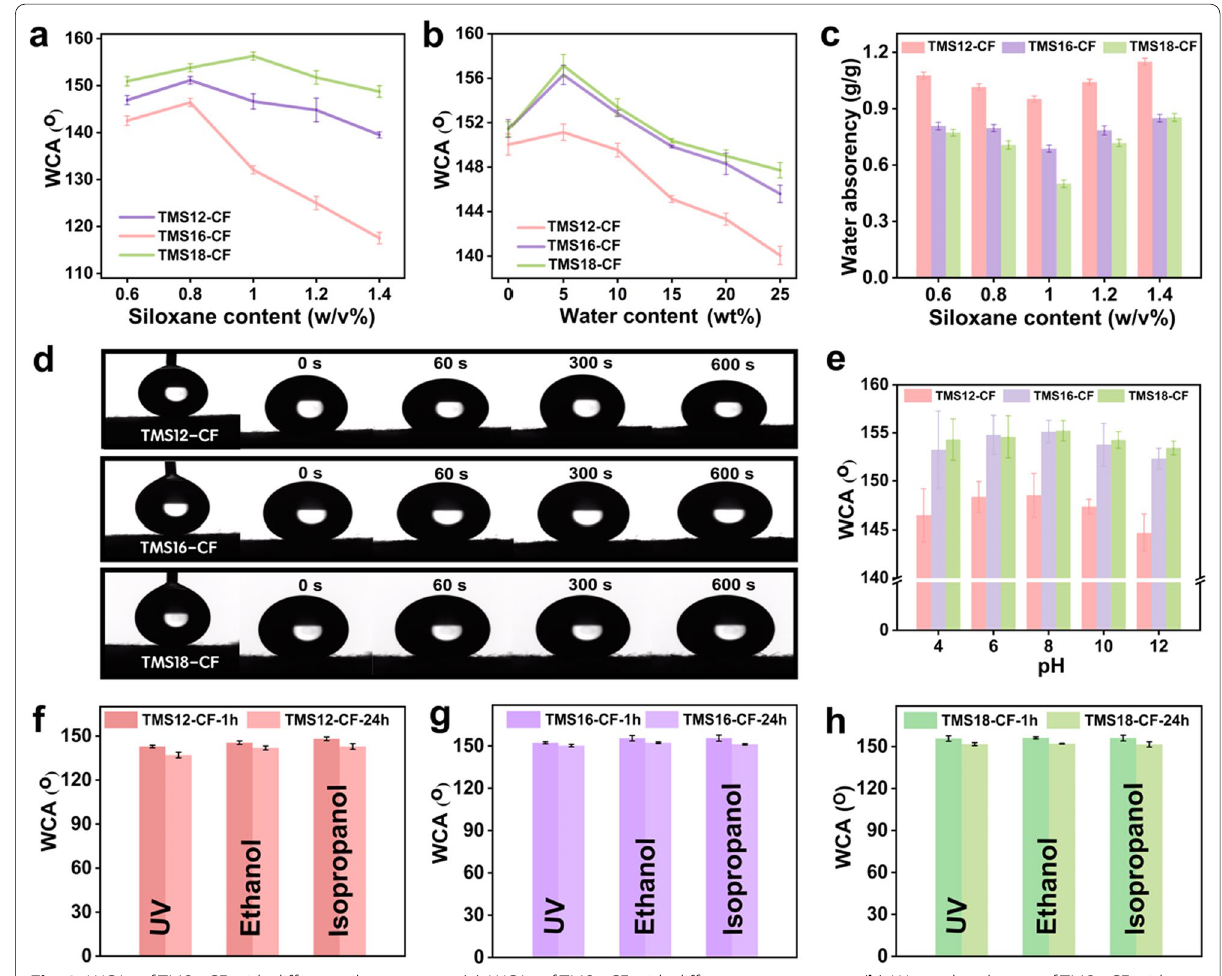
Fig. 3 WCAs of TMSx-CF with different silane content ( a ), WCAs of TMSx-CF with different water content ( b ), Water absorbency of TMSx-CF with different siloxane content ( c ), the shape of a water droplet on the TMS12-CF, TMS16-CF, TMS18-CF samples at different times ( d ), WCAs of the TMSx-CF treated by immersion in different pH solutions for 24 h ( e ), WCAs of the TMS12-CF ( f ), TMS16-CF ( g ), TMS18-CF ( h ) treated by UV for 1 h and 24 h, or immersion in various organic solvents for 1 h and 24